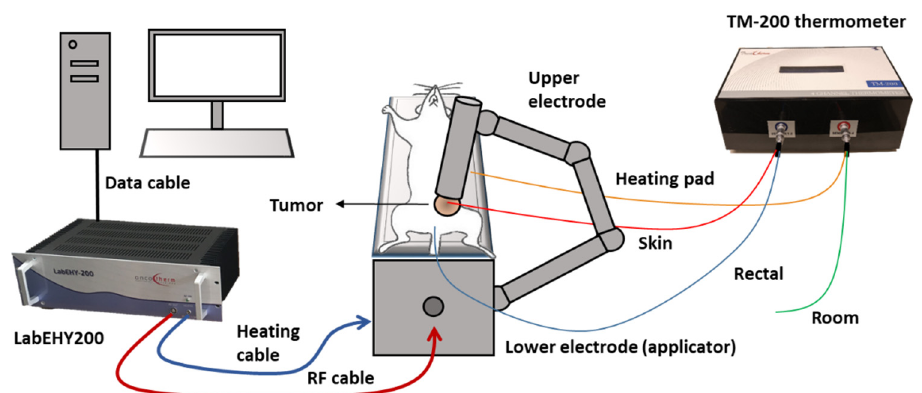
Figure 9. Schematic illustration of mEHT treatment setup. Mice were placed on the lower electrode (in vivo applicator) in isoflurane anesthesia. The upper electrode was positioned on the tumor in the inguinal region. The LabEHY200 was connected with the lower electrode with a radiofrequency (RF) and a heating cable. Temperature monitoring of tumor surface (red: skin temp. sensor), rectum (blue), heating pad (yellow) and room temperature (green) was performed by a TM-200 thermometer and the data were registered with a computer during the treatment.